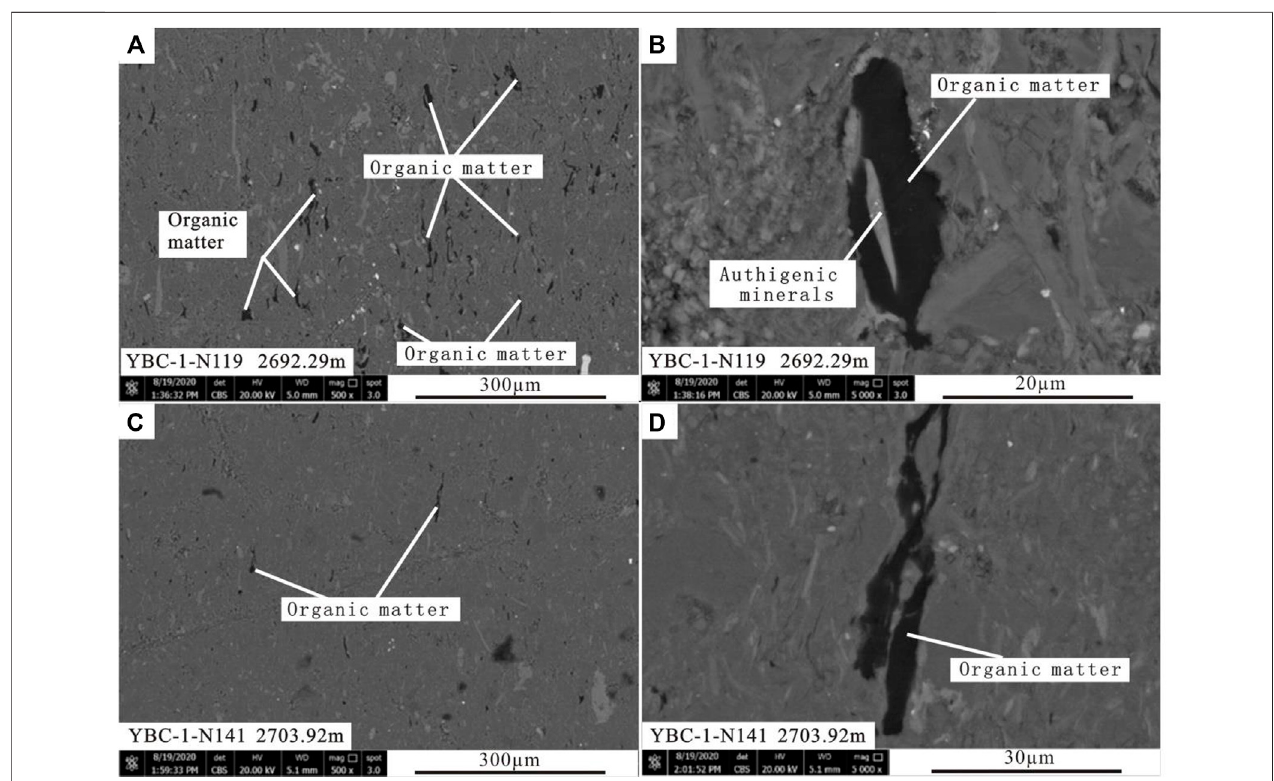
FIGURE 7 | SEM images of organic matter in Shanxi Formation shale. (A) organic matter pores; (B) organic matter pores with authigenic minerals fi ll in; (C,D) organic matter pores.